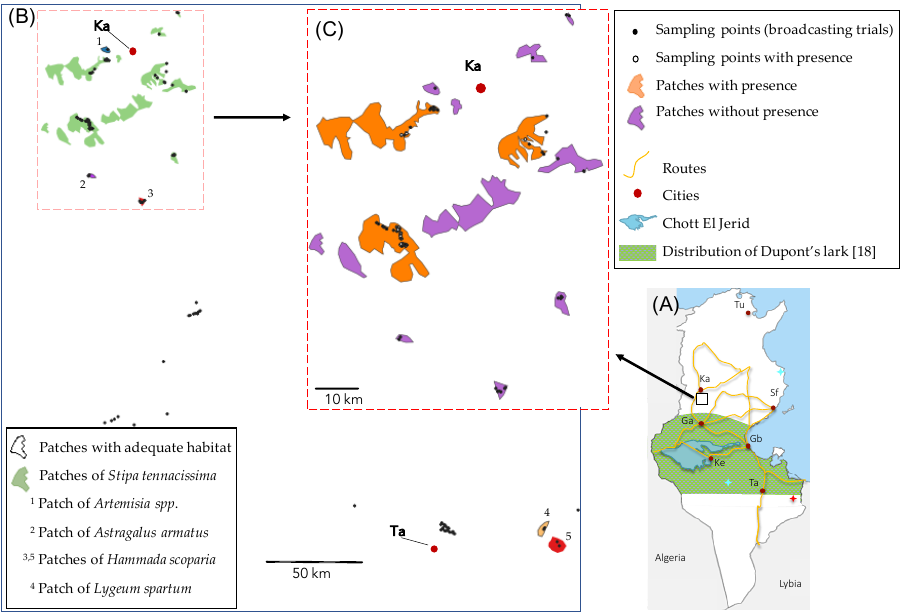
Figure 1. Detailed summary of the Dupont ´ s lark survey in Tunisia. ( A ) Map of Tunisia show- ing the breeding distribution of Dupont’s lark according to [18]. (Ka = Kasserine; Ga = Gafsa; Gb = Gabes; Ke = Kebili; Ta = Tataouine; Sf = Sfax; Tu = Tunis). The only recent record of the species (internet search) is marked as a red star (Sidi Toui National Park, [33]). Recent (after